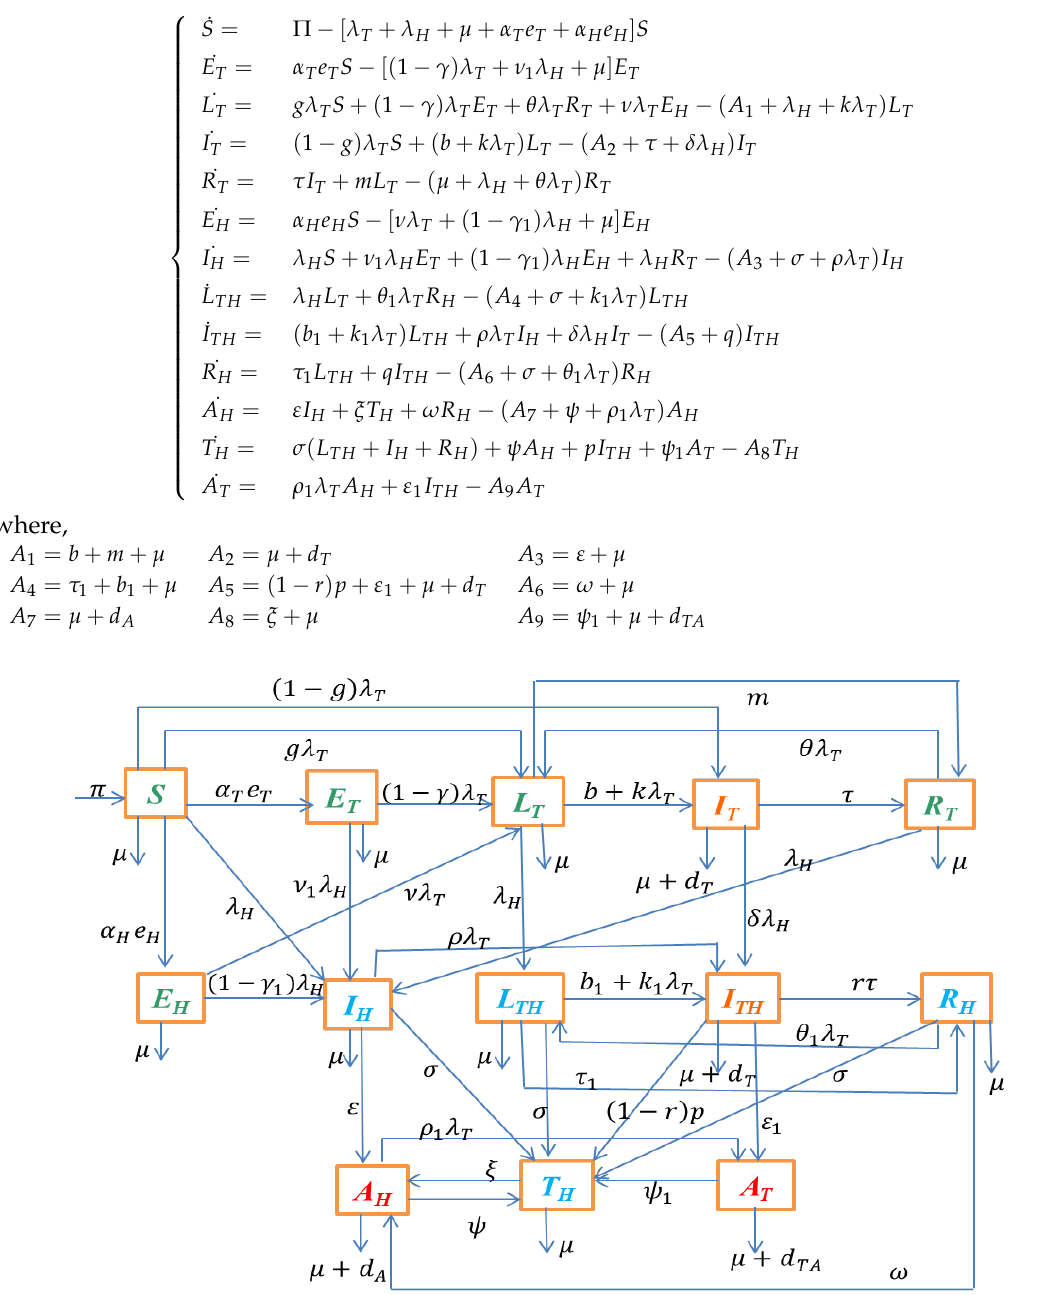
Figure 1. Schematic diagram for TB-HIV/AIDS compartmental model that includes behavior change and